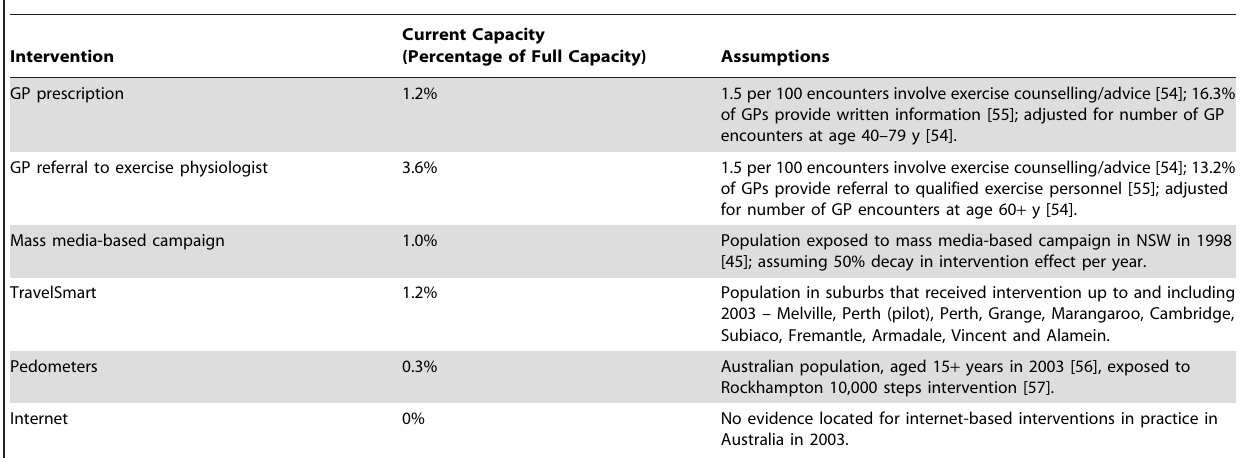
Table 2. Current practice for the six physical activity interventions in 2003.